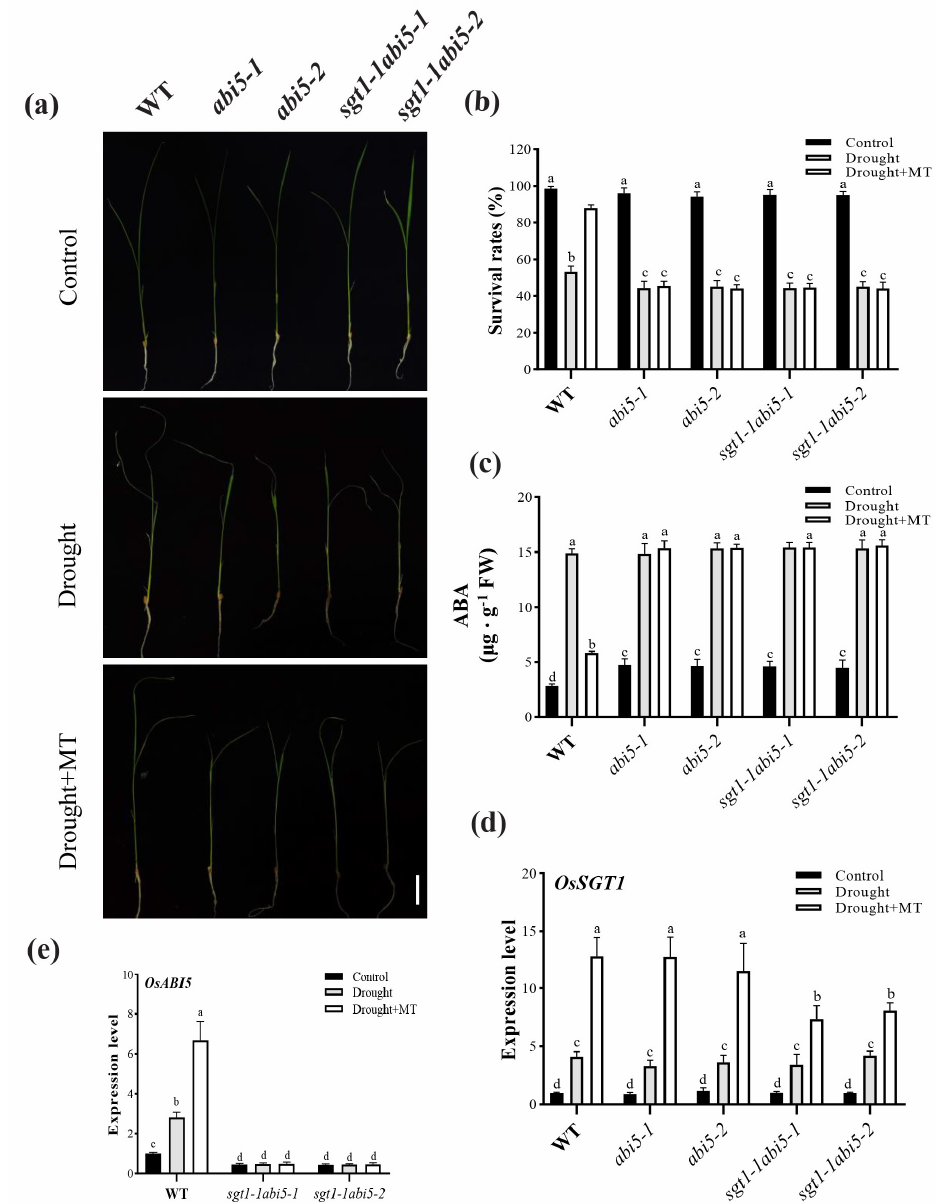
Figure 5. Effects of dual mutation of OsSGT1 and OsABI5 on the melatonin-alleviated drought stress. ( a ) Plant phenotype, ( b ) survival rates, ( c ) ABA contents, and the expression levels of ( d ) OsSGT1 and ( e ) OsABI5 , were examined in the leaves of wild-type (WT), sgt1, abi5 , and sgt1-1abi5 mutant seedlings treated with melatonin (MT; 100 µM) under drought stress. Difference in letters indicates significant differences according to Tukey’s Multiple Comparison Test ( p < 0.05). Bar = 3